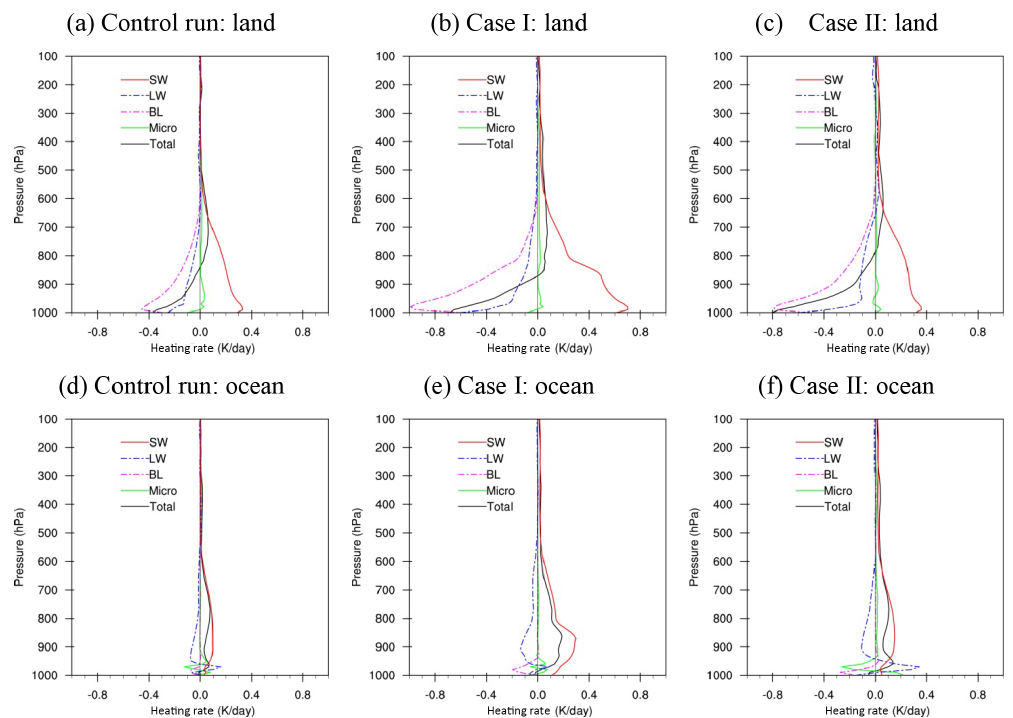
Figure 4. Calculated monthly mean heating rates (temperature tendency, d T/ d t , in Kday − 1 ) perturbed by aerosols, over land for (a) the con- trol run, (b) Case I, and (c) Case II, as well as over the ocean for (d) the control run, (e) Case I, and (f) Case II. The heating processes include shortwave (SW) radiation (red), longwave (LW) radiation (blue dashed), boundary mixing (BL, magenta dashed), and cloud microphysics (Micro, green). The total heating due to aerosol effects is shown with solid black